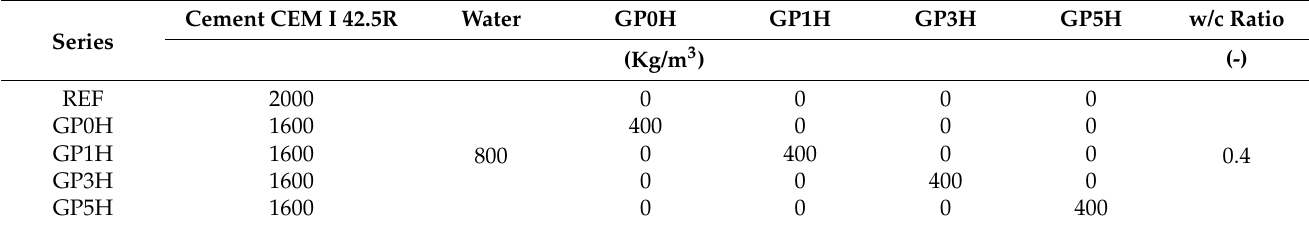
Table 2. Compositions of cementitious pastes used in